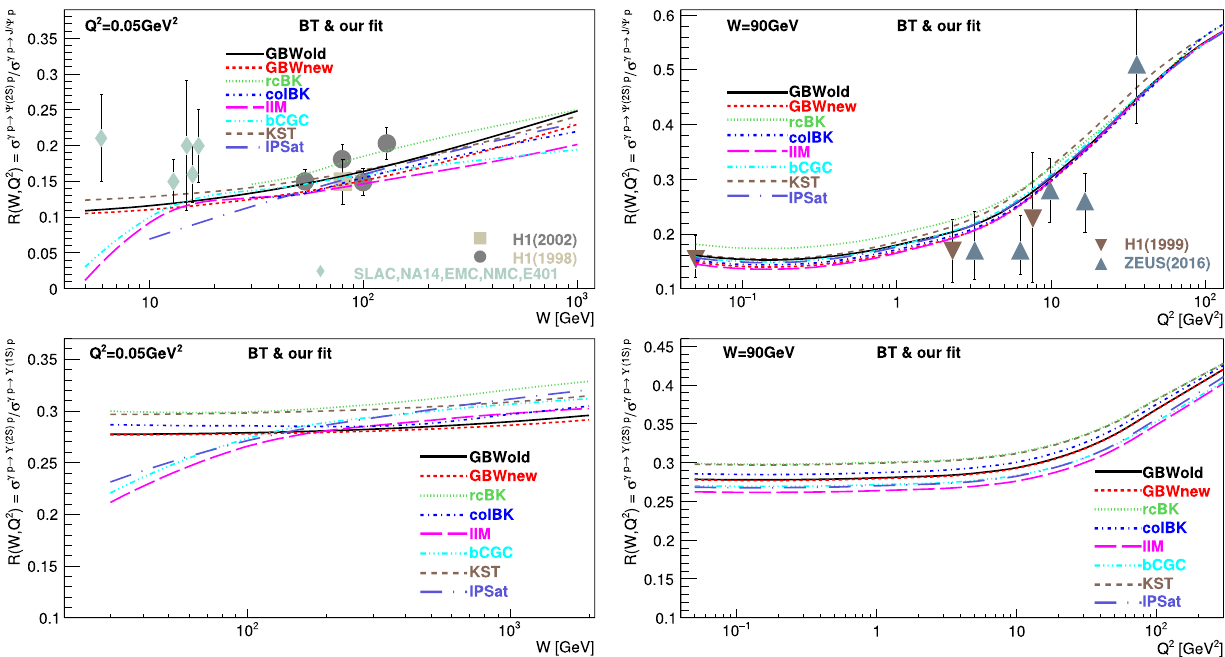
Fig. 22 The same as Fig. 21 but for the quakonium wave functions generated by the realistic BT potential and for different dipole cross section parametrizations described in Sect. 4